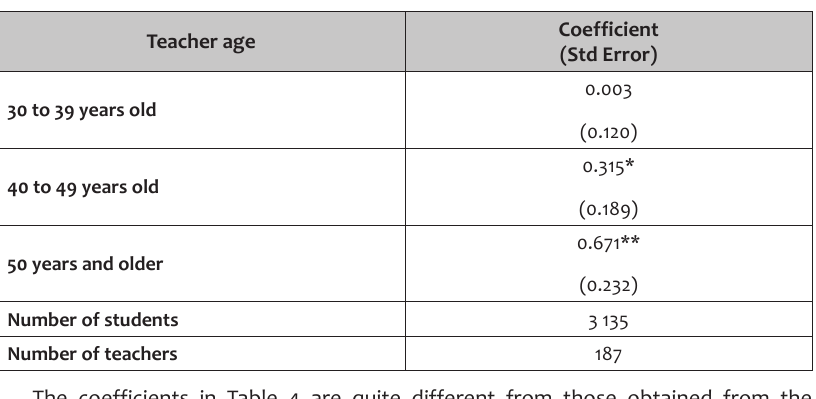
Table 4: HLM coefficients on teacher age variables using SACMEQ II (Source: Own calculations from SACMEQ II [SACMEQ